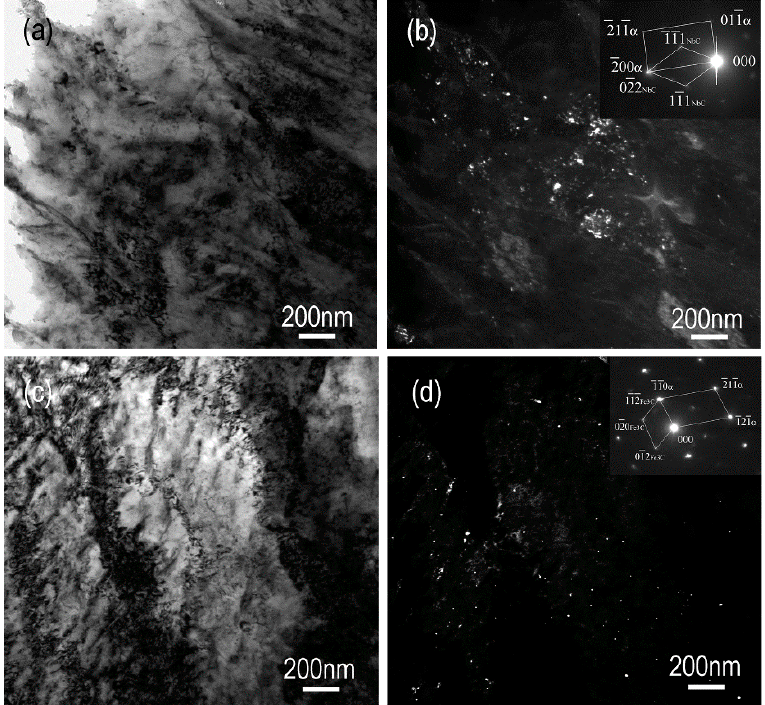
Figure 7. ( a ) BF and ( b ) DF micrographs of the retained austenite at 350 °C, with the corresponding SAED pattern inserted in ( b ).